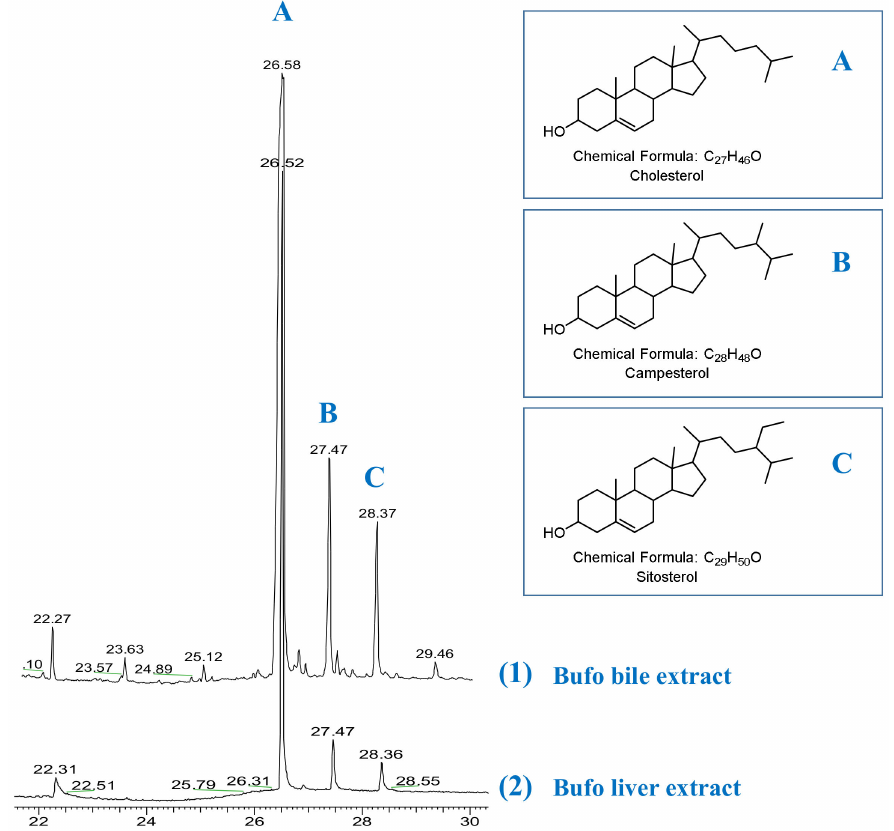
Figure 7. Gas–liquid chromatogram of the bile (trace 1) and liver (trace 2) extracts from bufo bufo gargarizans . The bile and liver of toads were extracted with 95% EtOH, concentrated, and partitioned with CH 2 Cl 2 . Then the CH 2 Cl 2 fractions were analyzed using a Thermo Trace 1300 ISQ-LT single quadrupole GC/MS spectrometer. The compound responses for peaks A–C were identified as ( A ) cholesterol, ( B ) campesterol, and ( C ) sitosterol, respectively, by comparing and matching with fragments in the Mainlib